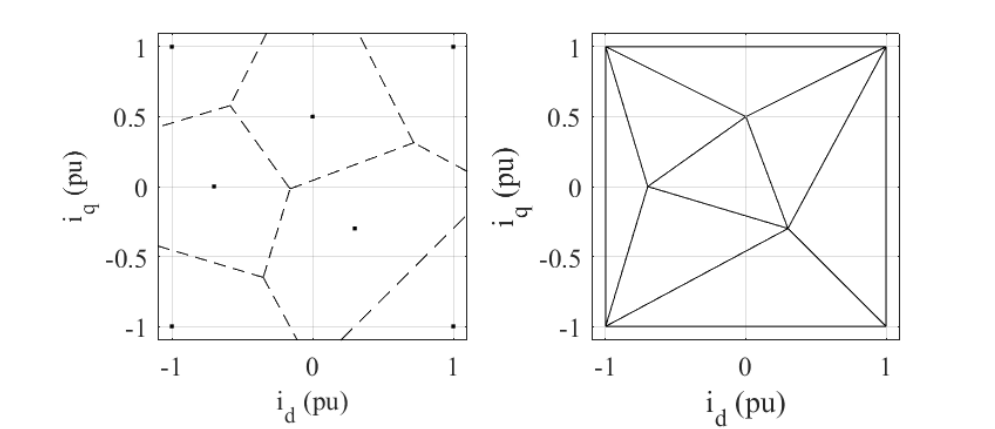
Figure 5. Voronoi diagram ( left ) of a seven-point irregular current grid and the corresponding eight-simplex Delaunay triangulation ( right